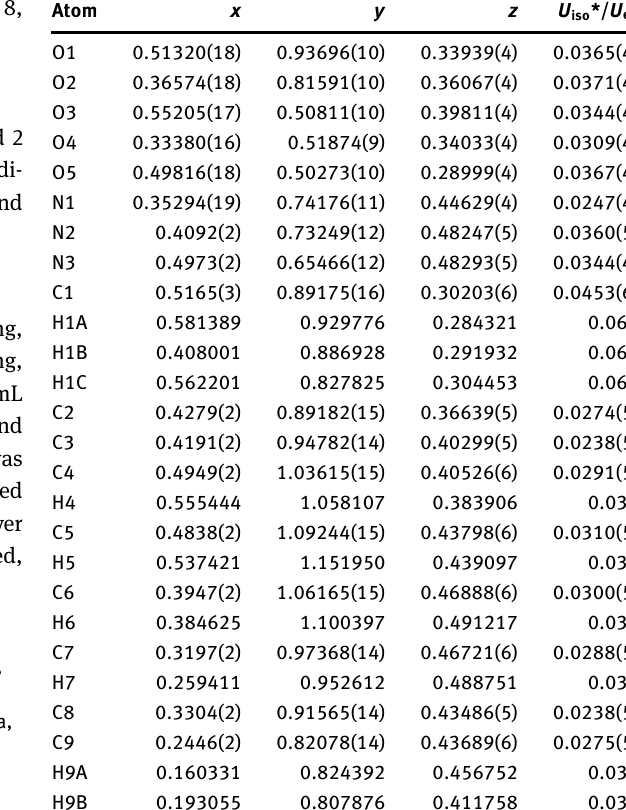
Table 2: Fractional atomic coordinates and isotropic or equivalent isotropic displacement parameters (Å 2